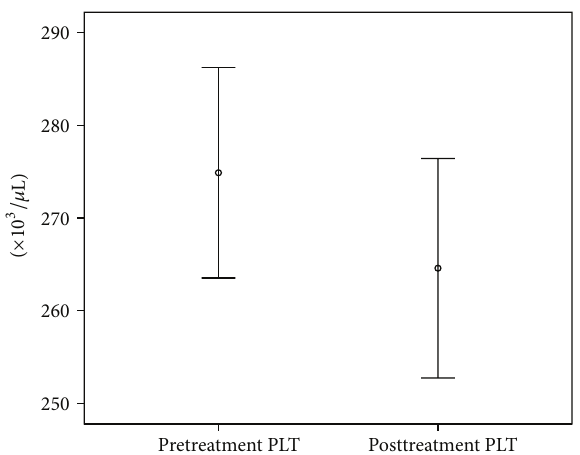
Figure 2: MPV levels prior to and following the